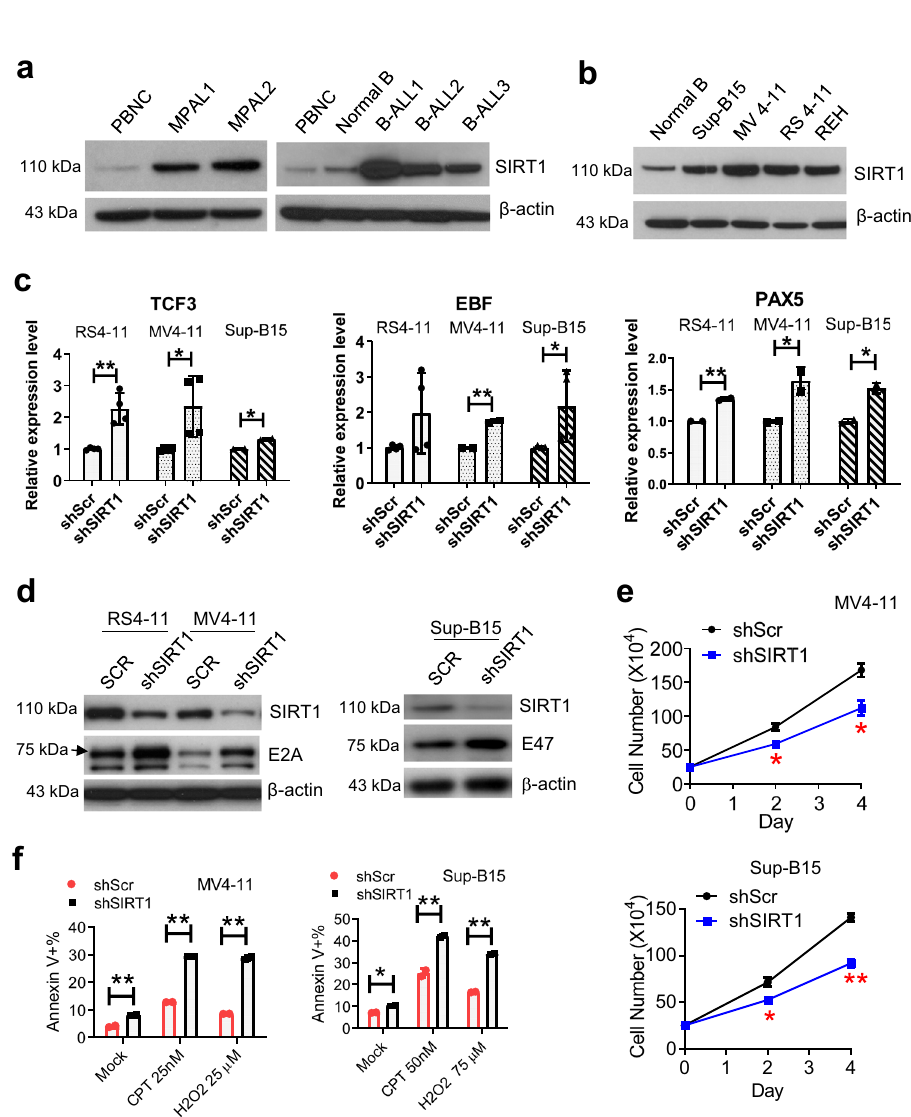
Fig. 5 SIRT1 gene expression in human MPAL cells and regulation of human B-cell-speci fi c genes. a SIRT1 protein expression in human adult B/M MPAL and B-ALL. Normal B: puri fi ed normal human B cells that contained >95% CD19 + cells. PBNC: total peripheral blood nucleated cells. Ficoll-enriched primary leukemia samples contained 85 – 95% blasts. The age of patients was ranged from 27 to 60. b SIRT1 protein expression in MPAL and B-ALL cell lines. c Realtime RT-PCR analysis of TCF3, EBF and PAX5 expression in MPAL and B-ALL cell lines after SIRT1 knockdown. shScr scrambled shRNA. d Western blot analysis of E2A or the large splice variant of E2A, i.e. E47, upon SIRT1 knockdown. e Effects of SIRT1 knockdown on growth of MV4-11 and Sup-B15 cells. f Effects of SIRT1 knockdown on cell apoptosis in the absence and presence of camptothecin (CPT) or H 2 O 2 treatment. * P < 0.05; ** P < 0.01. Error bars represented one standard